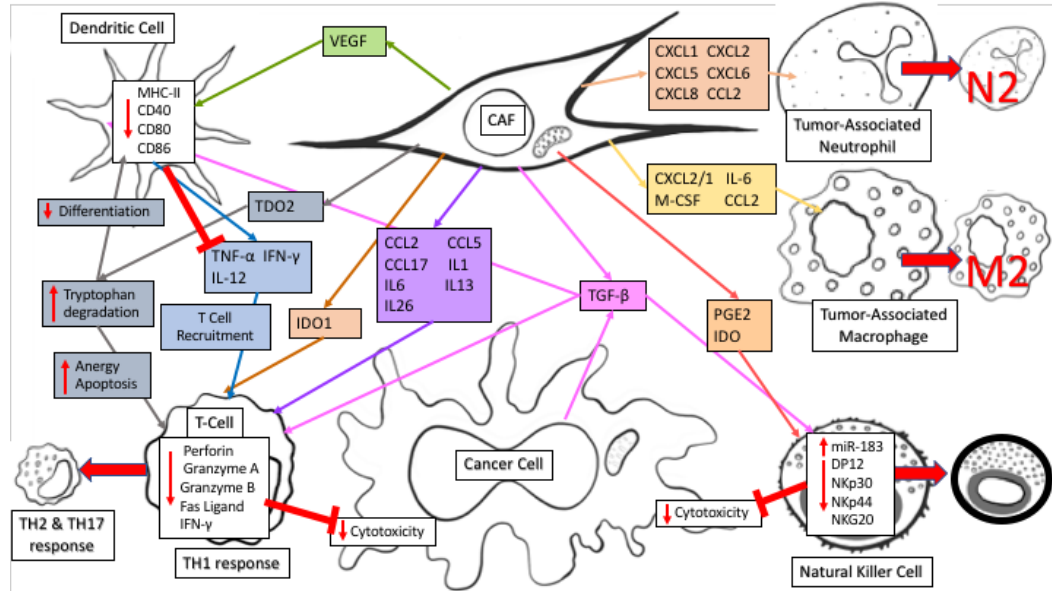
Figure 1. CAF secretions of immunomodulatory factors regulate anti-tumor immune response. CAF